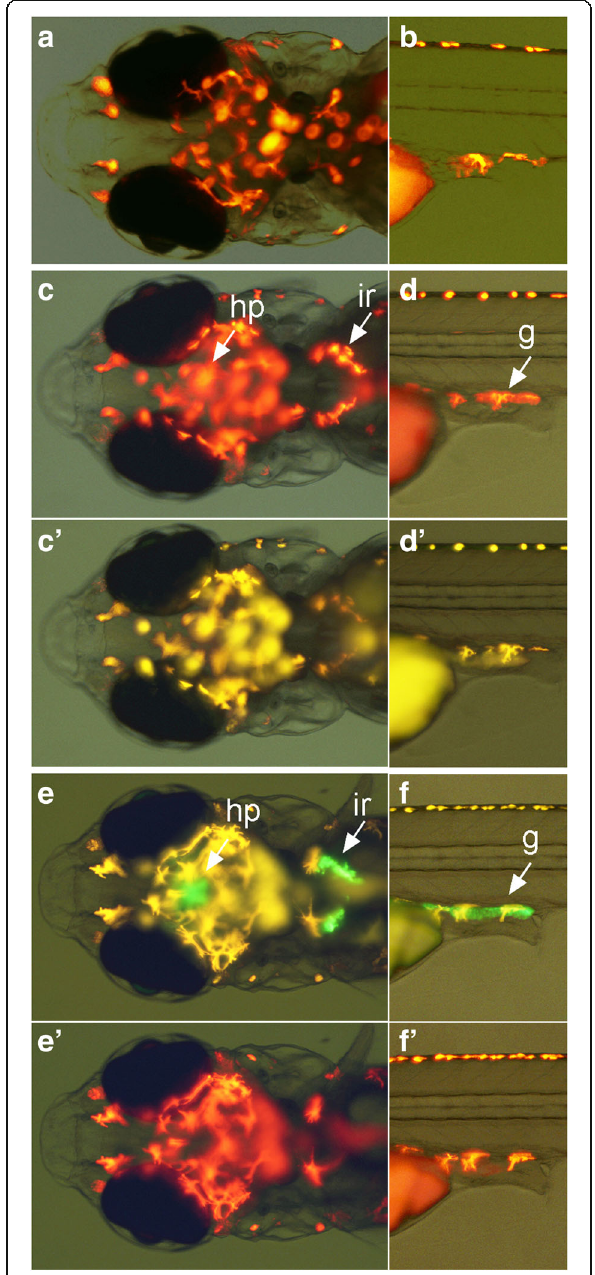
Fig. 3 Generation of Tg[nr5a1-hs:lRl-GFP] and Tg[nr5a1-hs:GFP] transgenic fish. ( a , b ) Dorsal view of the head region ( a ) and lateral view of the trunk region ( b ) of a control larva at 9dpf with an RFP filter set. Red signals are from the auto-fluorescence of pigment cells. ( c , d ) Tg[nr5a1-hs:lRl-GFP] transgenic fish viewed with an RFP filter set. RFP is expressed in cells in the hypothalamus (hp), interrenal gland (ir), and gonad (g). Note that the red signals are not auto-fluorescence, as the corresponding signals are absent in a control larva ( a and b ). (c', d') Tg[nr5a1-hs:lRl-GFP] transgenic fish viewed with a GFP filter set. No GFP expression is present. ( e , f ) Tg[nr5a1-hs:GFP] transgenic fish with a GFP filter set. GFP is expressed in cells in the hypothalamus (hp), interrenal gland (ir), and gonad (g). Yellow signals are from the auto-- fluorescence of pigment cells. (e', f') Tg[nr5a1-hs:GFP] transgenic fish viewed with an RFP filter set. No RFP expression is